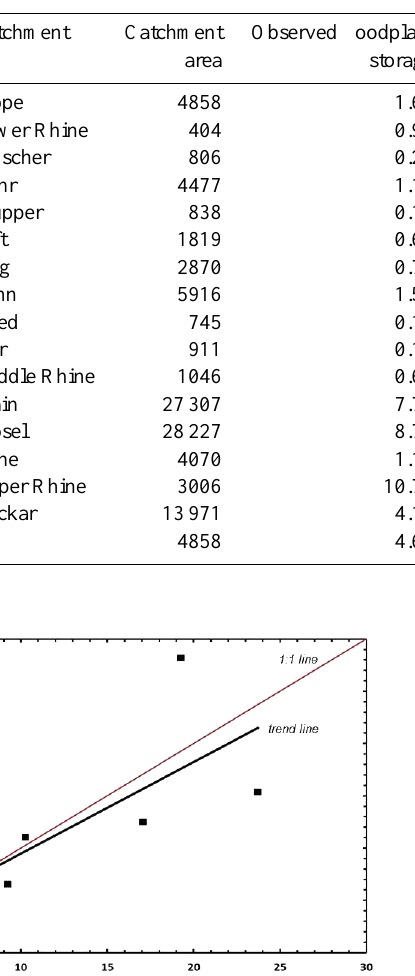
Table 6. Observed versus simulated sediment storage (Gt) for Rhine sub-catchments. The sub-catchment area is given in km 2 . Data on the observed sediment storage are taken from Hoffmann et al. (2007).